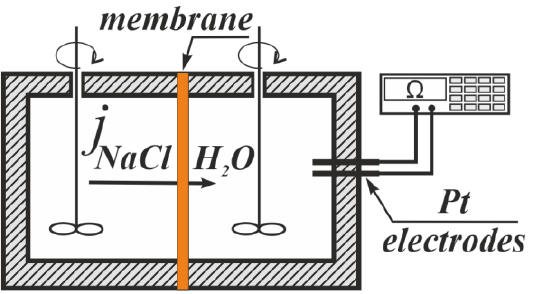
Figure 2. The experimental setup for the diffusion permeability measurement.